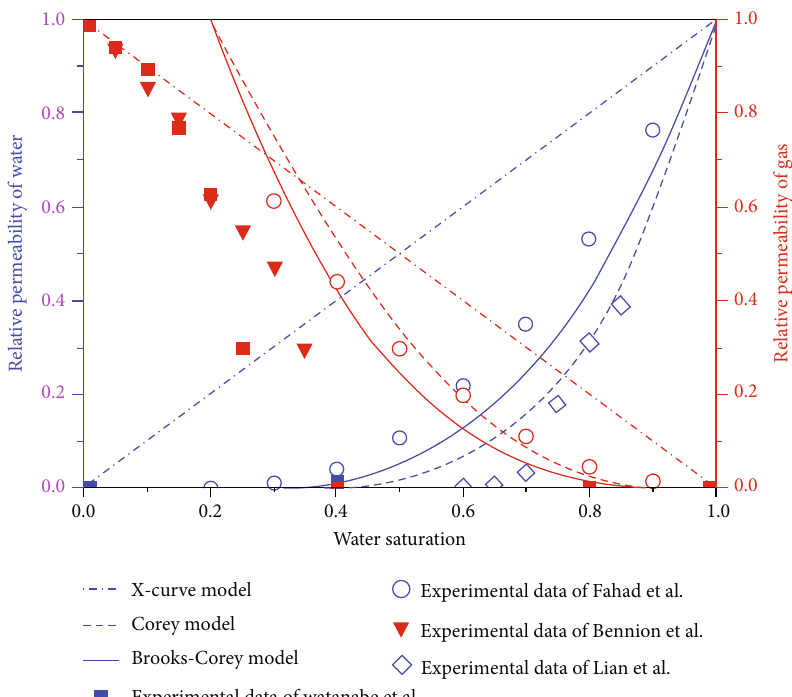
Figure 1: Results of relative permeability from Watanabe et al. [17], Fahad et al. [18], Bennion and Bachu [19], and Lian et al. [20]. Several traditional relative permeability models, such as the X-curve model [21], Corey model [22], and Brooks-Corey model [23] are also shown. (Note: For the same symbol, red refers to gas relative permeability, while blue refers to water relative permeability.)